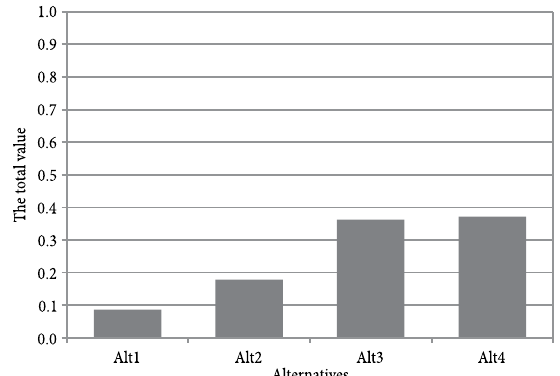
Fig. 5. Resulting graph of the case-based municipality assessment